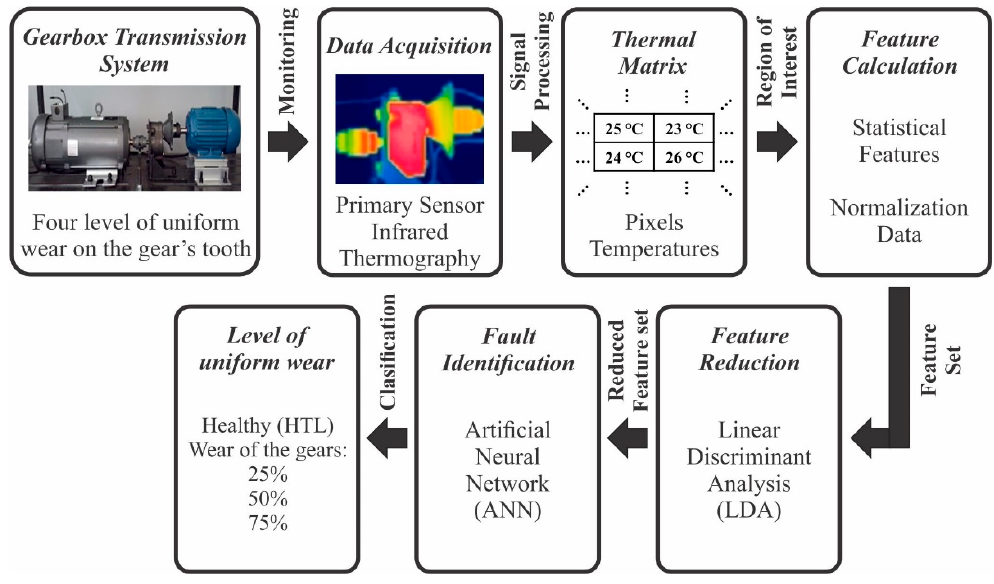
Figure 1. Methodology proposed to identify gear tooth wear in a gearbox transmission system.